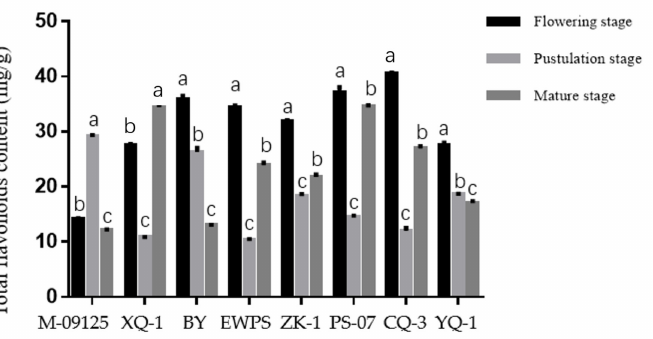
Figure 1. Total flavonoids content of tartary buckwheat varieties at different growth stages. The value is flavonoids (mg) per gram dry matter basis. M-09125: Meng-09125; XQ-1: Xiqiao No. 1; BY: Buyue; EWPS: Ewu Pedgree selection; ZK-1: Zhaoku No. 1; PS-07: Pedgree selection-07; CQ-3: Chuanqiao No.3 and YQ-1: Youqiao No. 1. Different lowercase letters on each column indicate significant differences between stages at p < 0.05.